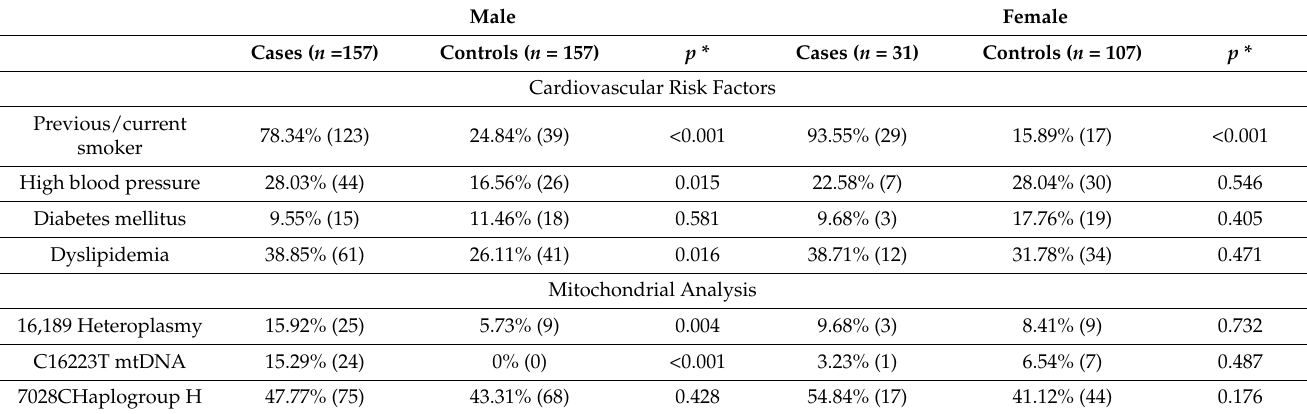
Table 2. Clinical characteristics and mitochondrial characteristics divided by gender.